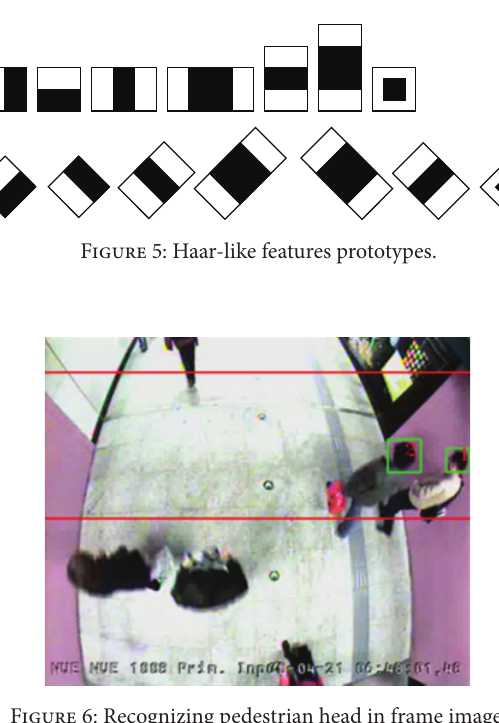
Figure 6: Recognizing pedestrian head in frame